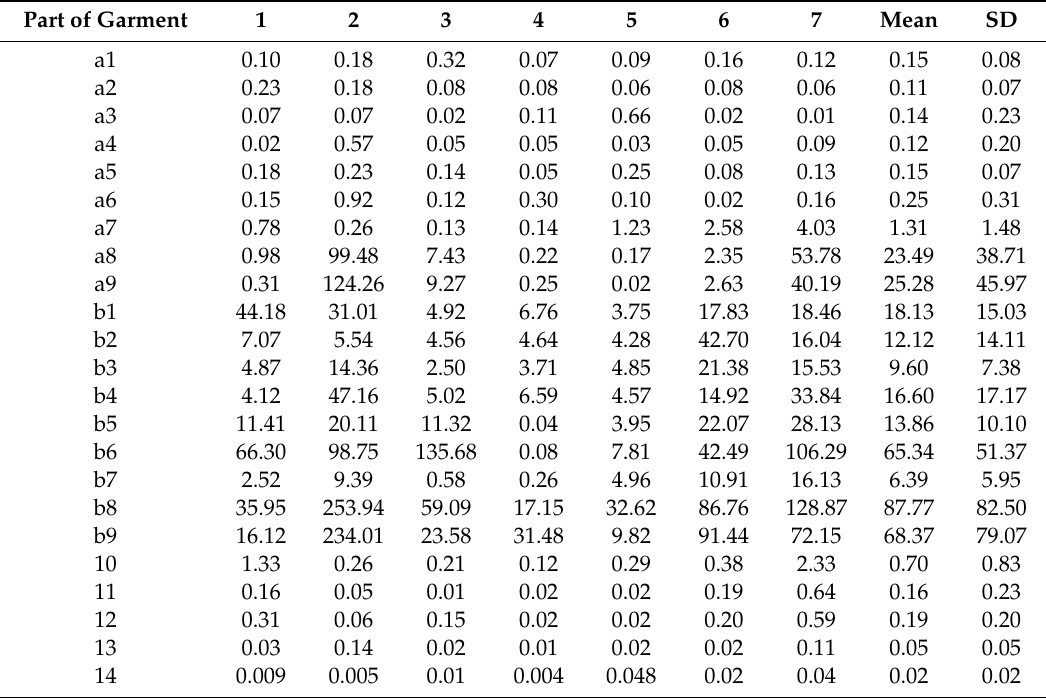
Table 2. Unit exposures at various parts of the body (mg / kg a.i. handled).